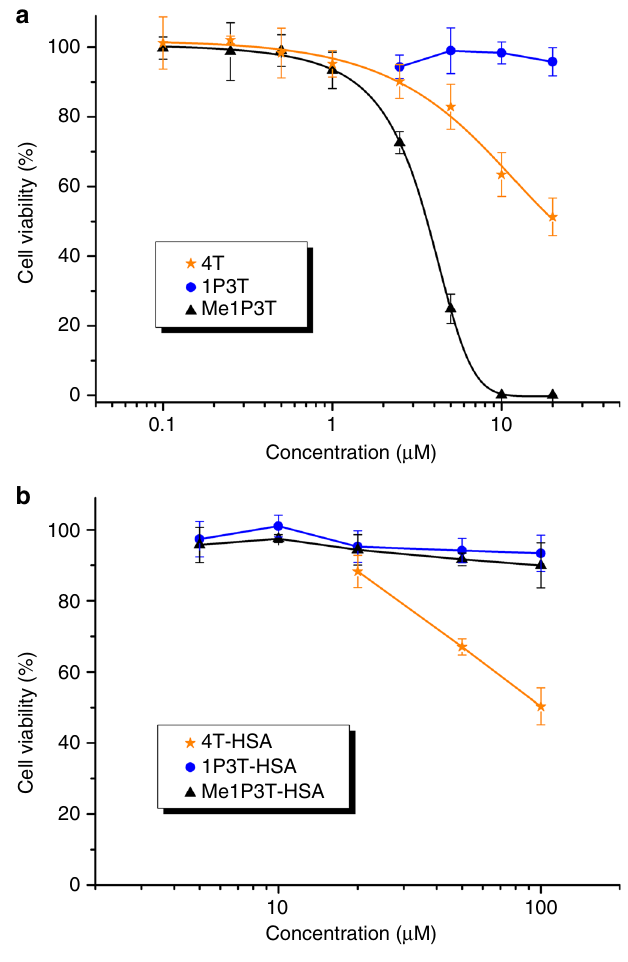
Fig. 5 Signi fi cantly reduced cellular toxicity of the oligothiophene-HSA complexes. a , b Precultured A549 cells were separately treated with 4T, 1P3T, Me1P3T and 4T-HSA, 1P3T-HSA, Me1P3T-HSA, respectively, at various concentrations for 24 h and analyzed in a CellTiter-Glo Luminescent Cell Viability Assay. For the free oligothiophenes, solubility of the compounds limits the test to ≤ 20 µ M. The intensity of luminescence directly correlates to the amount of living cells. Data presented were measured in independent triplicates. In particular, a signi fi cant toxicity difference was observed between Me1P3T (IC 50 , 3.45 µ M) and Me1P3T- HSA (IC 50 , > 100 µ M). The data represented as mean ± SEM, n =